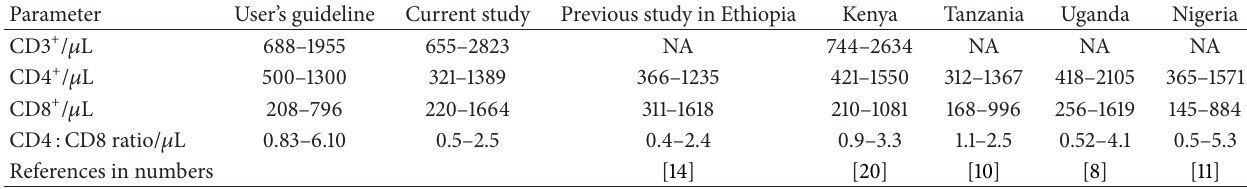
Table 5: The overall 95% normal reference interval for Tlymphocytes in HIV negative adults in the current study as compared to other African